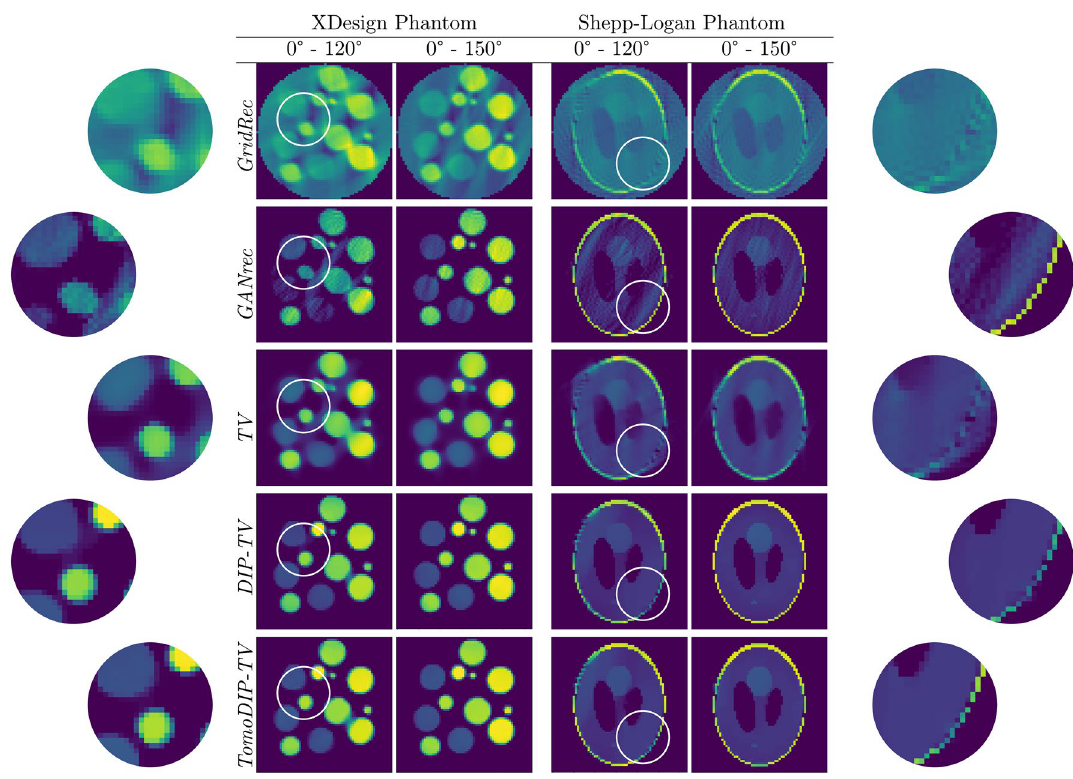
Figure 6. Reconstruction comparison for the XDesign phantom and the Shepp–Logan phantom for the noise- free case. XDesign 3D Noise free reconstruction